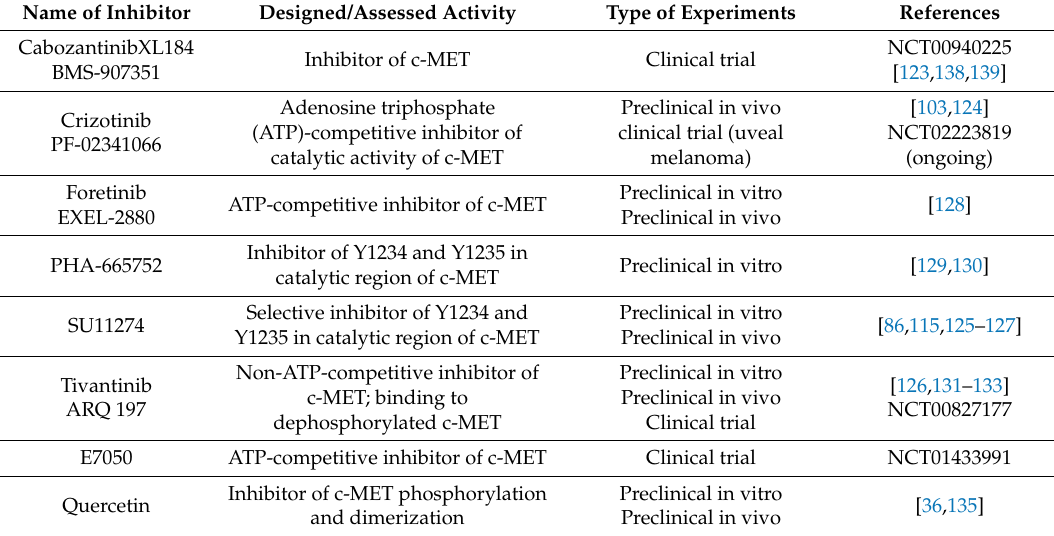
Table 1. Inhibitors of HGF/c-MET signaling investigated in melanoma cells, in preclinical and clinical